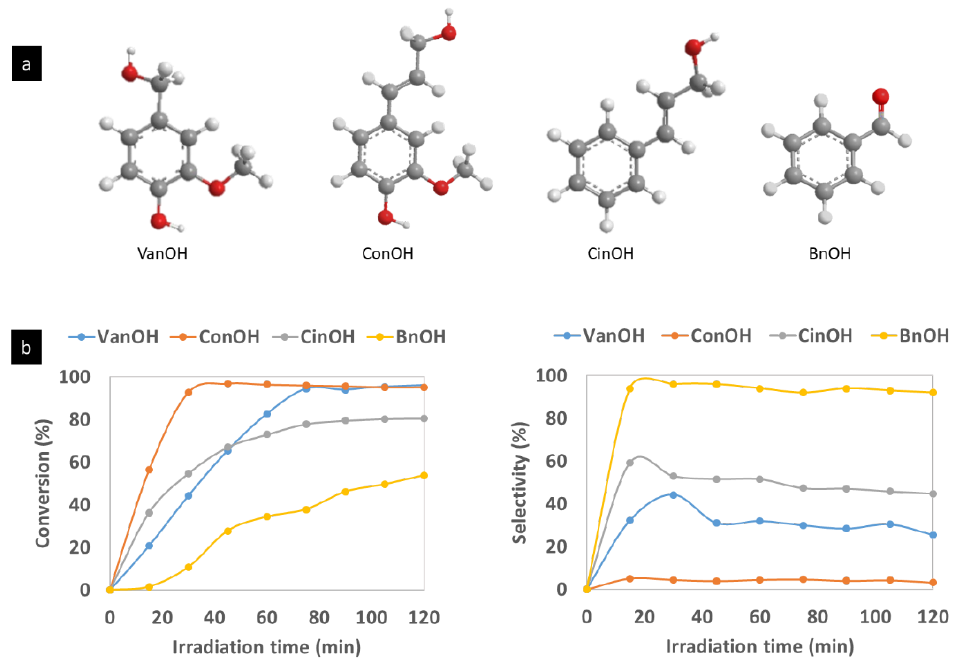
Figure 7. Chemical structure of the aromatic alcohols (vanillyl alcohol (VanOH), coniferyl alcohol (ConOH), cinnamyl alcohol (CinOH), and benzyl alcohol (BnOH)) (atomic representation: white—hydrogen, grey—carbon, and red—oxygen) ( a ) and photocatalytic oxidation with CuA-Au/TiO 2 under UV light with 1 mM of aromatic alcohols in the batch system ( b ).